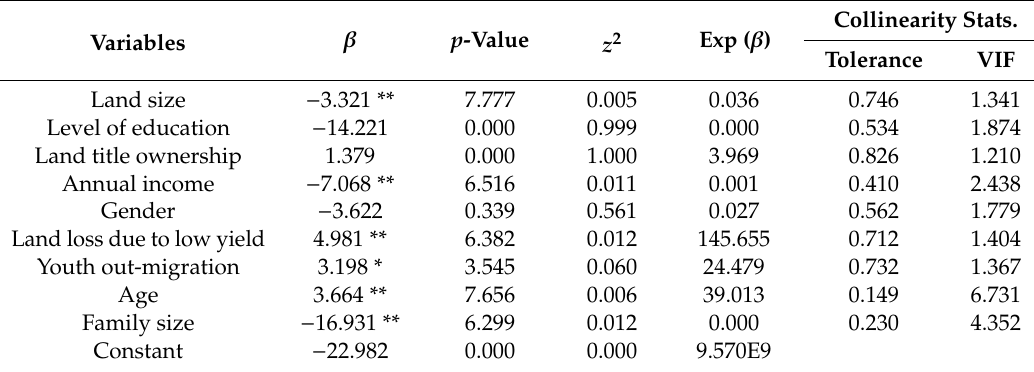
Table 4. E ff ects of variables of agricultural land